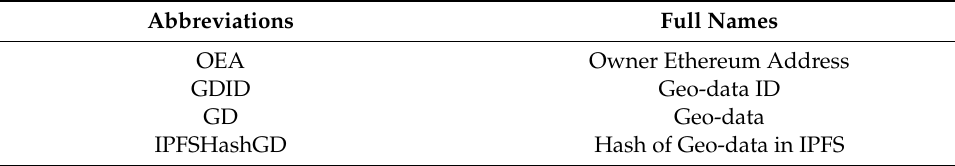
Figure 2. Mapping relationships in GDRM-OM. Table 3. Abbreviations and corresponding full names in